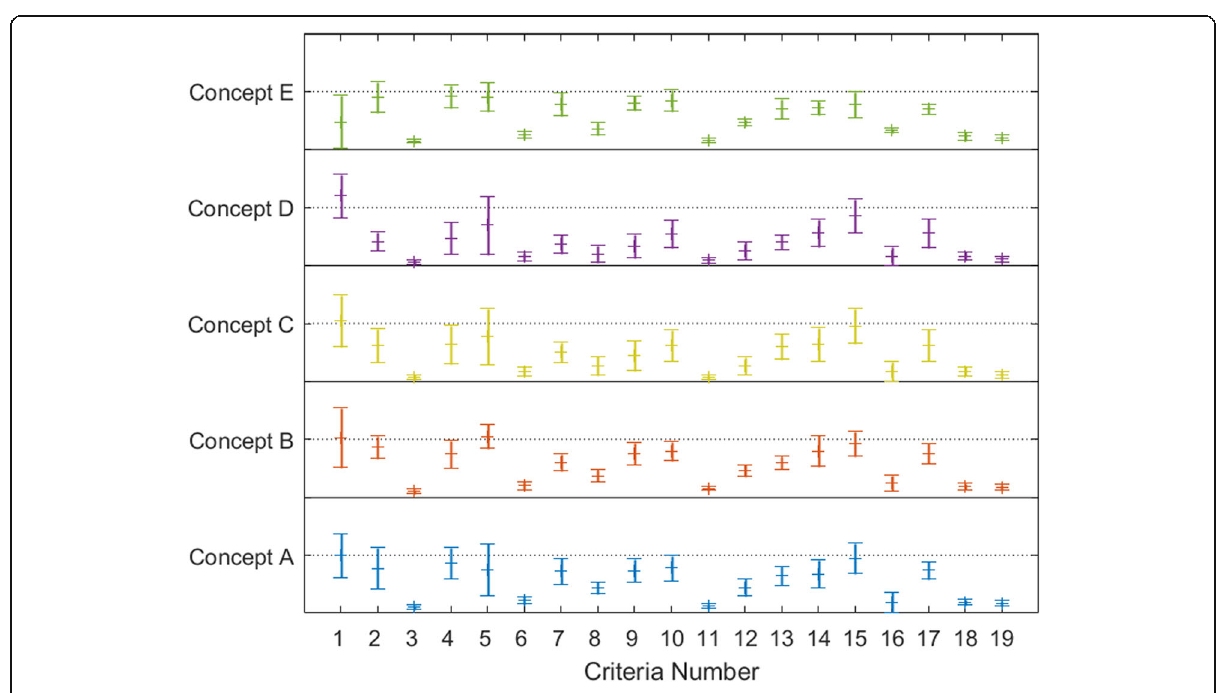
Fig. 3 Evaluation of selected